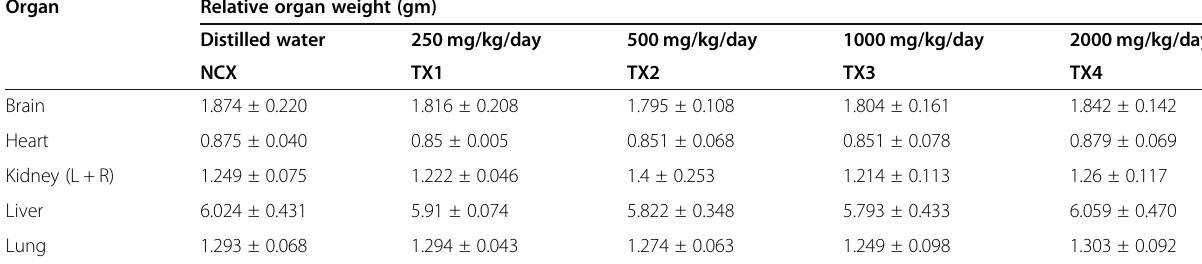
Table 4 Effect of oral administration of polyherbal combination (PHC) on relative organ weight (g) of mice Organ